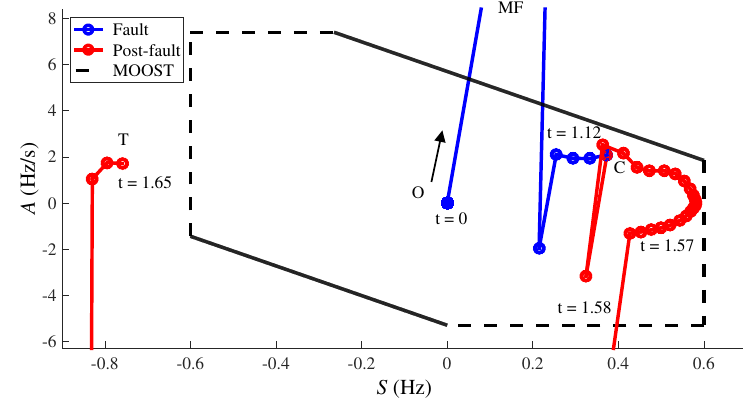
Figure 12. MOOST scheme operation on OP2. Table 6. Detailed ASS operation.